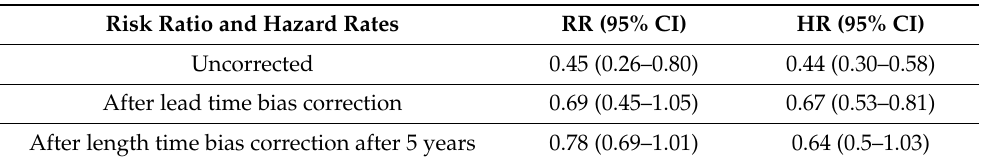
Table 2. Risk ratio and hazard rates of death for small M3 tumors in comparison to larger M3 UM. Lead time bias correction with an estimated sojourn time of 1 year still demonstrates a lower risk of death due to metastatic disease